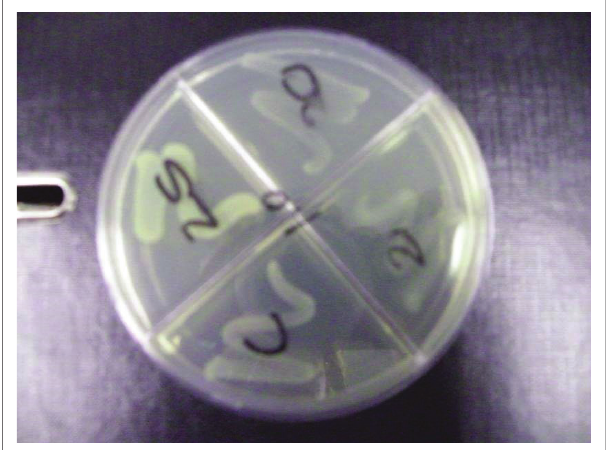
FIGURE 1 : Adapted mutant prevention concentration method plate – With C being the control, the other each section an antibiotic